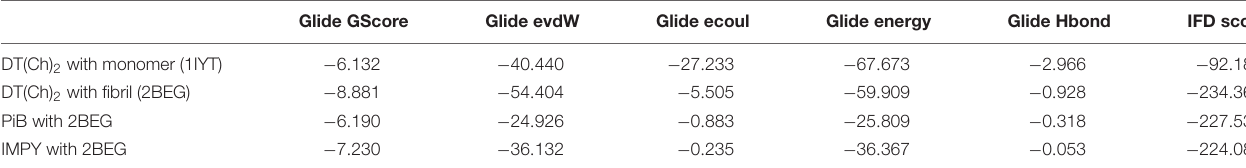
TABLE 1 | Thermodynamic parameters of induced-fit docking.